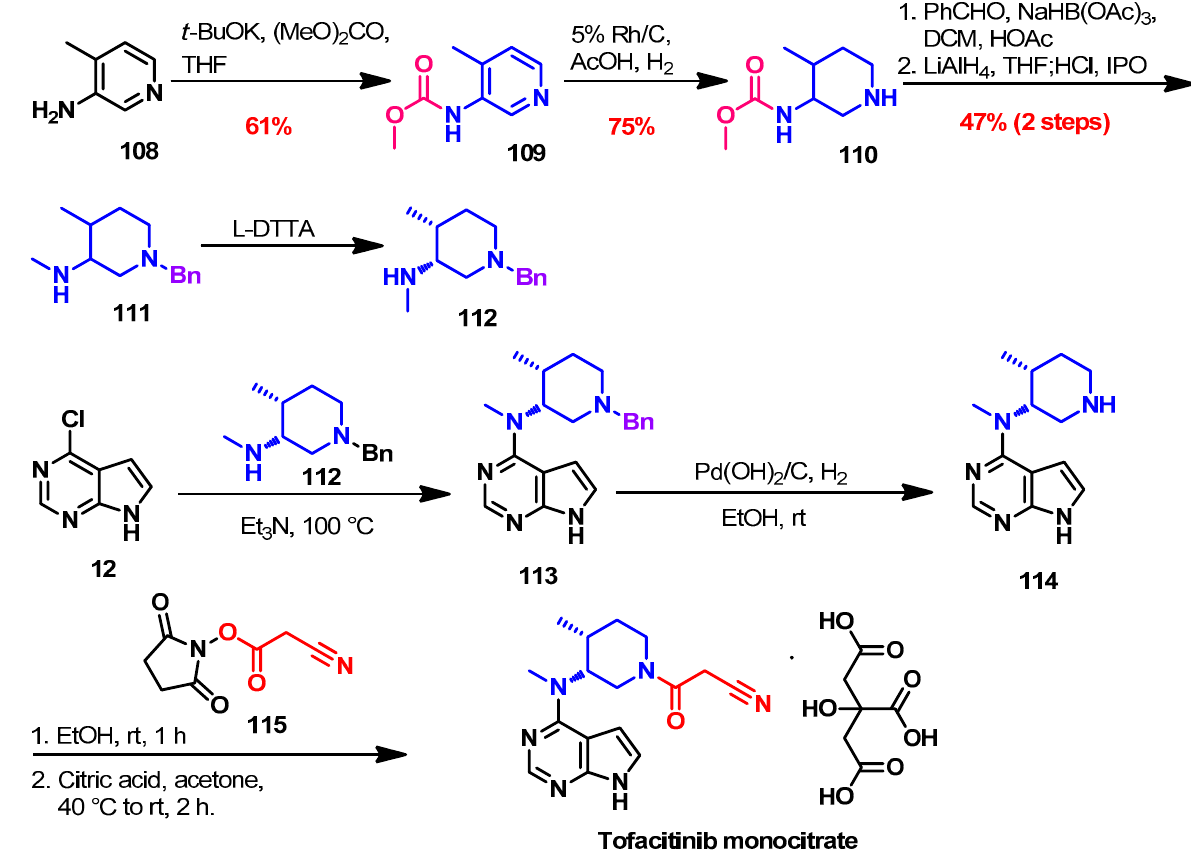
Scheme 14. Synthesis of tofacitinib citrate.